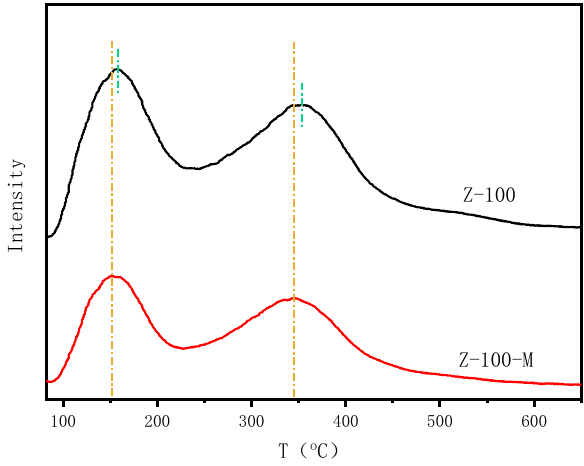
Figure 9. The NH 3 -TPD profiles of the mesoporous ZSM-5 and common ZSM-5 catalysts.